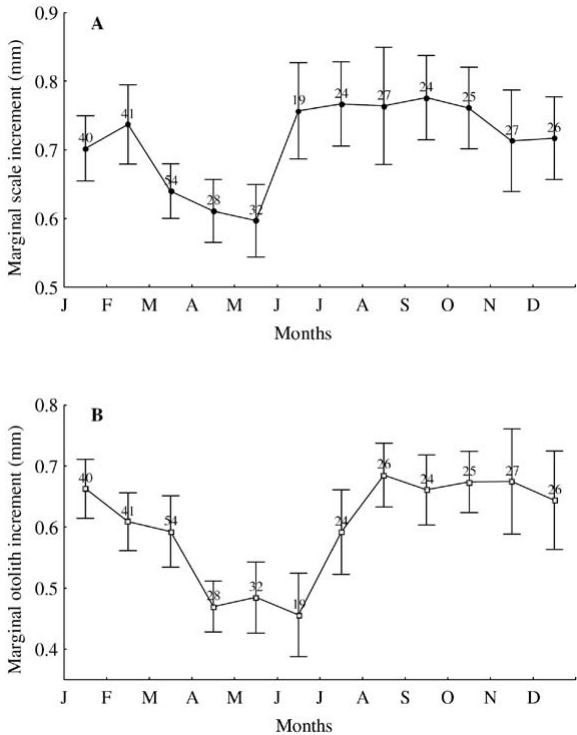
Fig. 2. – Mean monthly marginal increments of scales (A) and otoliths (B) of Spondyliosoma cantharus from the Gulf of Tunis. The errors bars represent ± standard error with monthly sample size above.